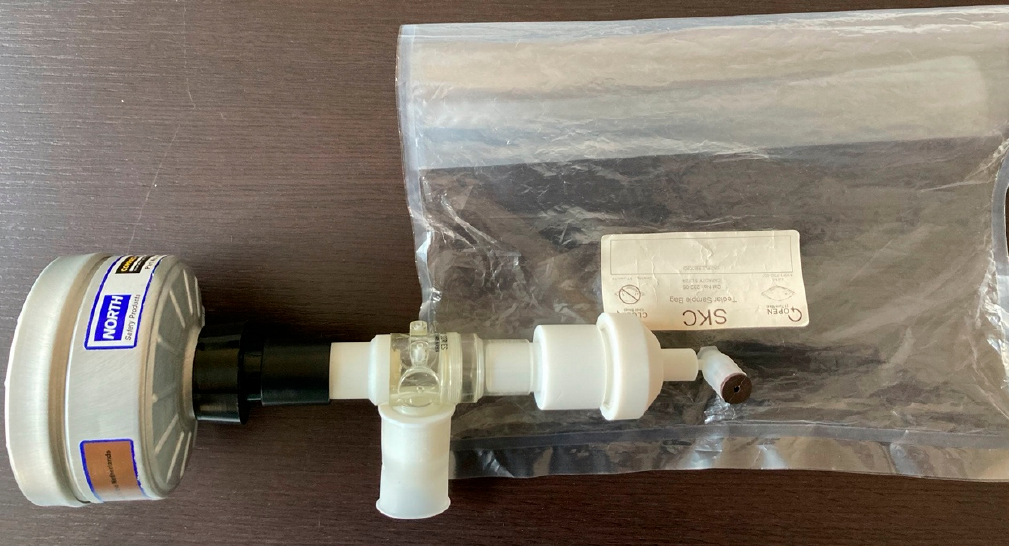
Figure 1. Setup for breath collection. From left to right: A2-environmental VOCs filter; 2-way non rebreathing valve; expiratory port; tedlar bag.